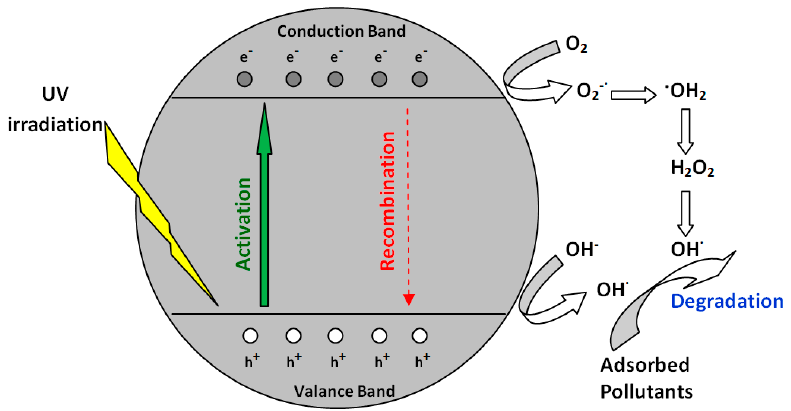
Figure 1. Scheme of the photocatalysis.